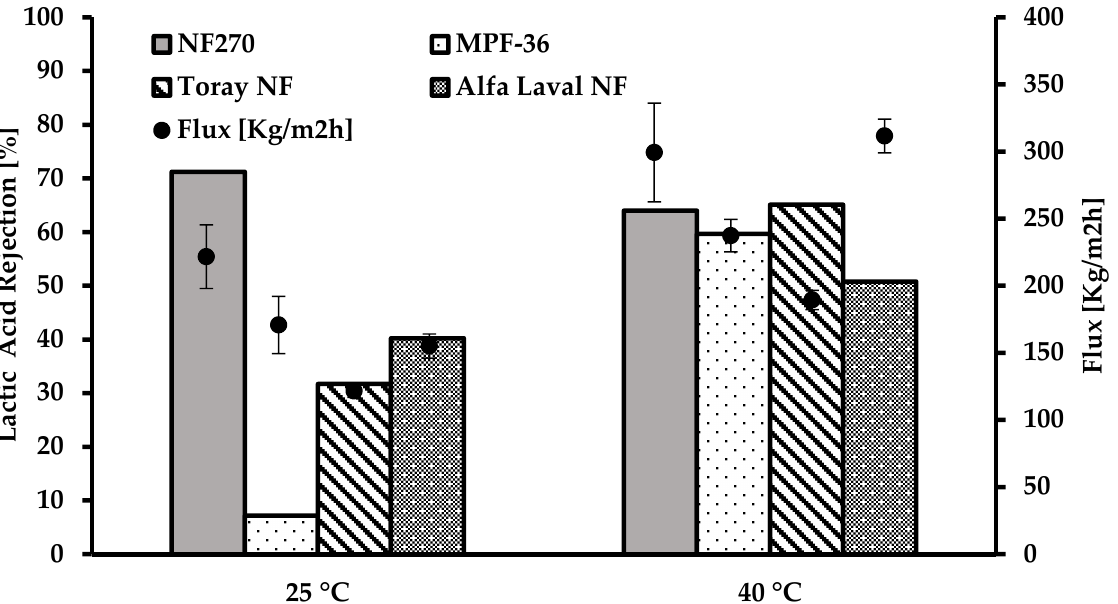
Figure 7. Rejection of lactic acid at different temperatures and flux variation.